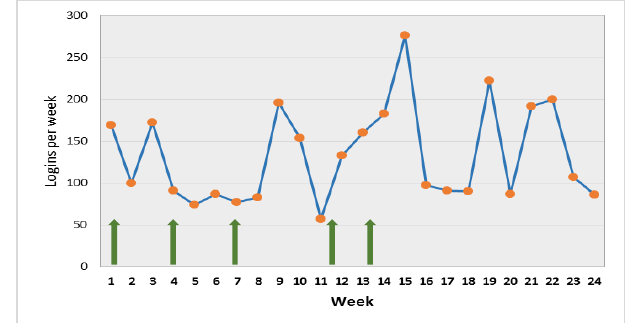
Table 1. Students’ creative and interaction